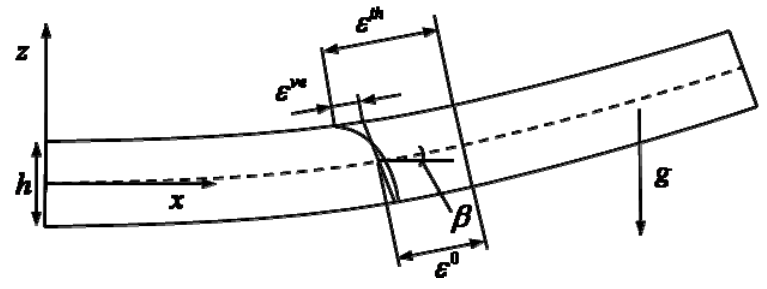
Figure 1: Strains in